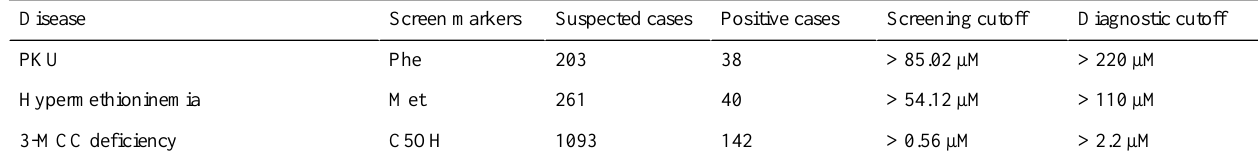
Table 1. Summary of the disease data collected from neonates between 2006 and 2011